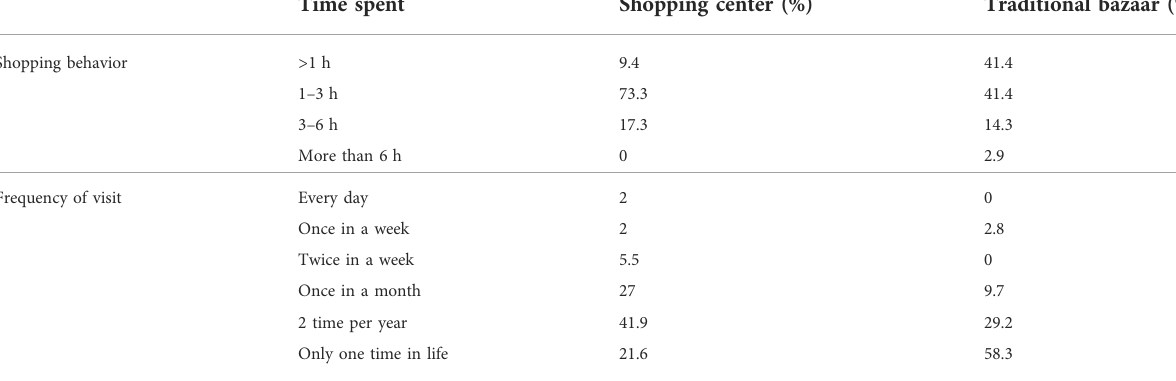
TABLE 2 Shopping behavior and frequency to visit shopping center and traditional